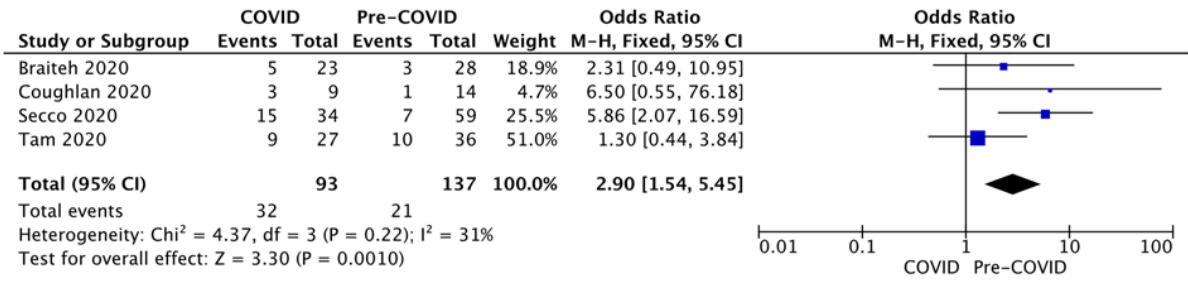
Figure 7. Forest plots for LVEF at presentation.